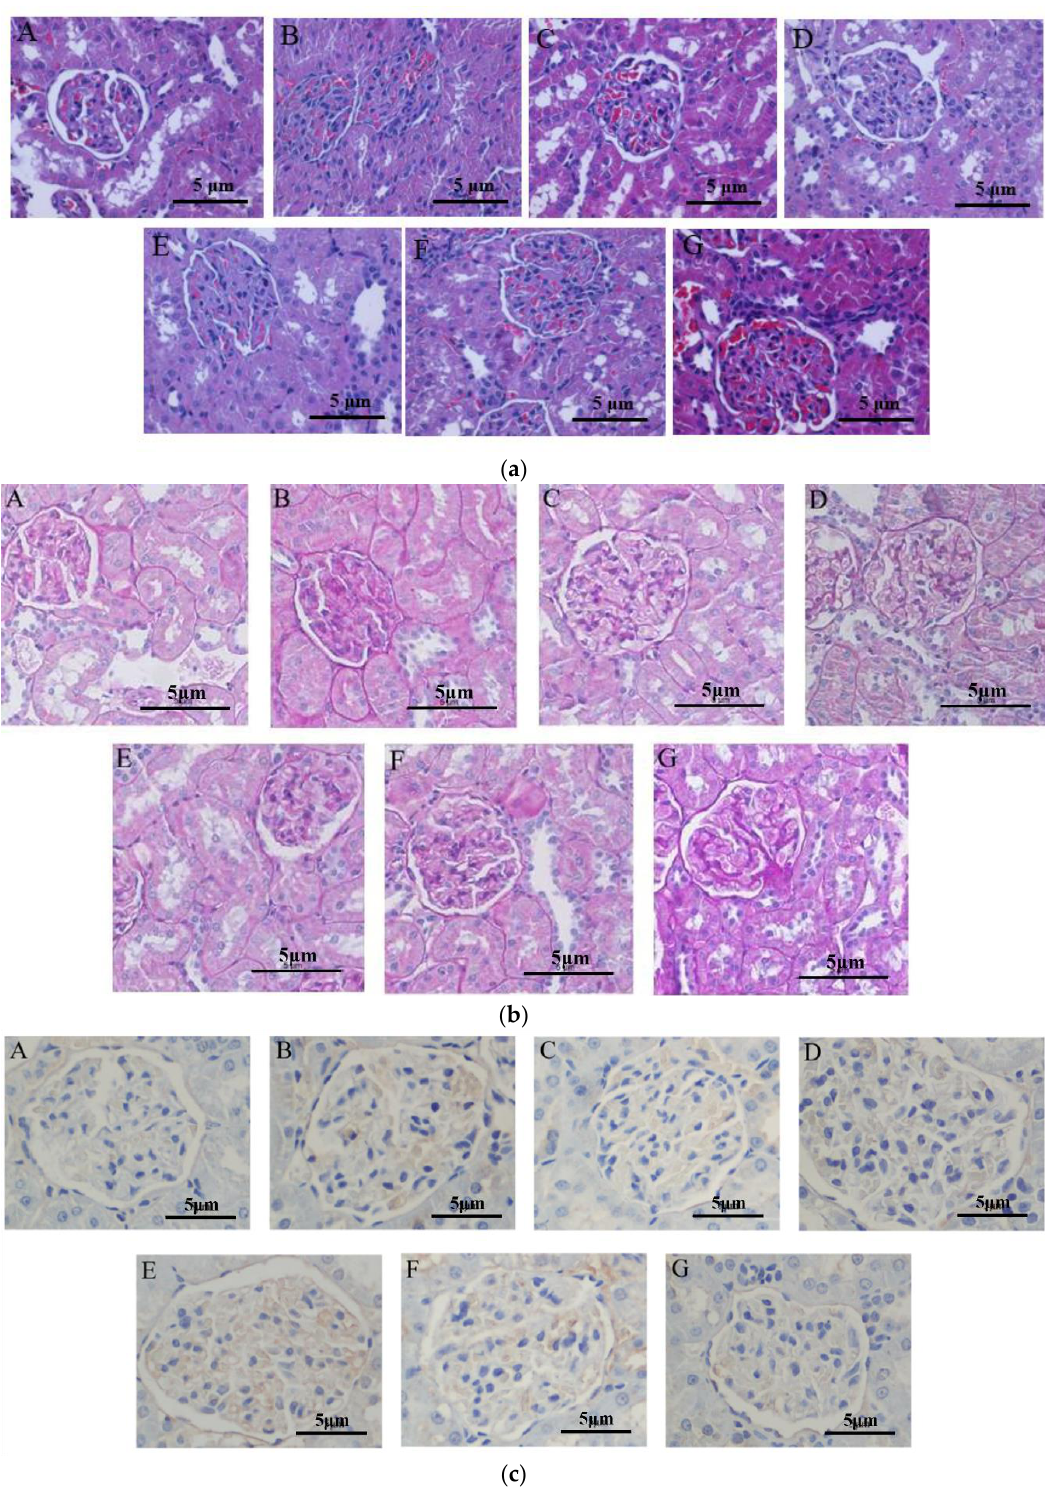
Figure 5. Periostracum cicadae improves kidney inflammation and fibrosis and induces cell apoptosis. ( a ) Hematoxylin and eosin (H&E) staining. ( b ) Periodic acid-Schiff (PAS) staining. ( c ) TdT-mediated dUTP nick end-labeling (TUNEL) staining.